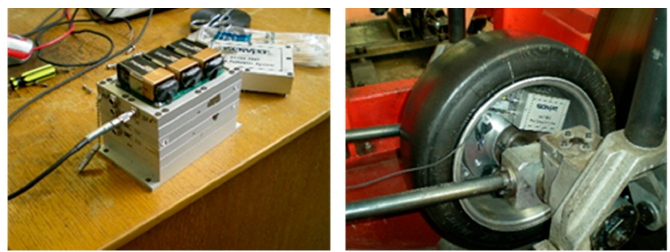
Figure 4. SoMat ® 2000 installed in the tire.